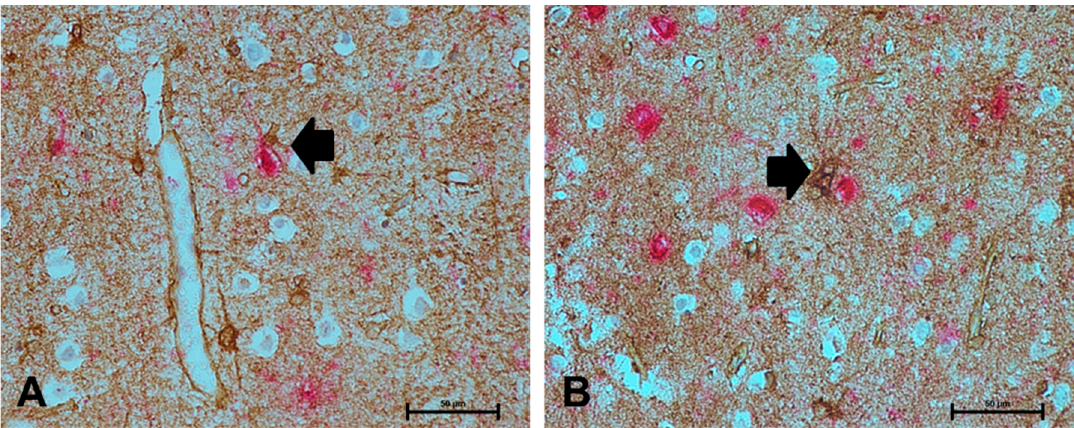
Figure 4. NDRG2 + astrocytes associate with neurofibrillary tangles (NFT) in the ageing brain. ( A – B ) NDRG2 + astrocytes (brown) associated with AT8 immunoreactivity (red), as indicated by the black arrow. Scale bar represents 50 μ m.